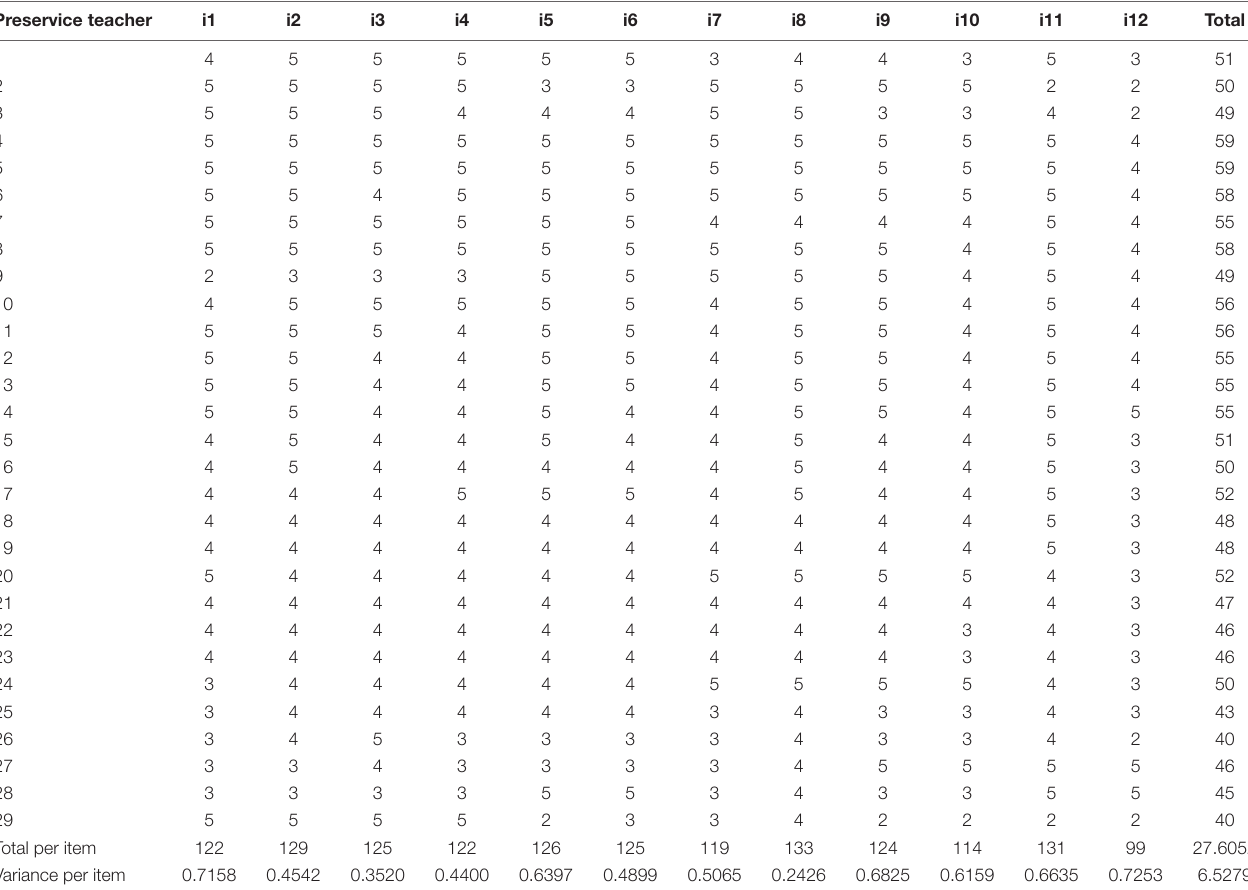
TABLE 3 | Table of responses and variance